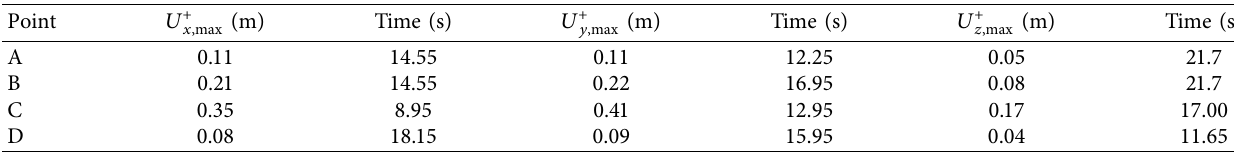
Table 3: Maximum positive displacement.